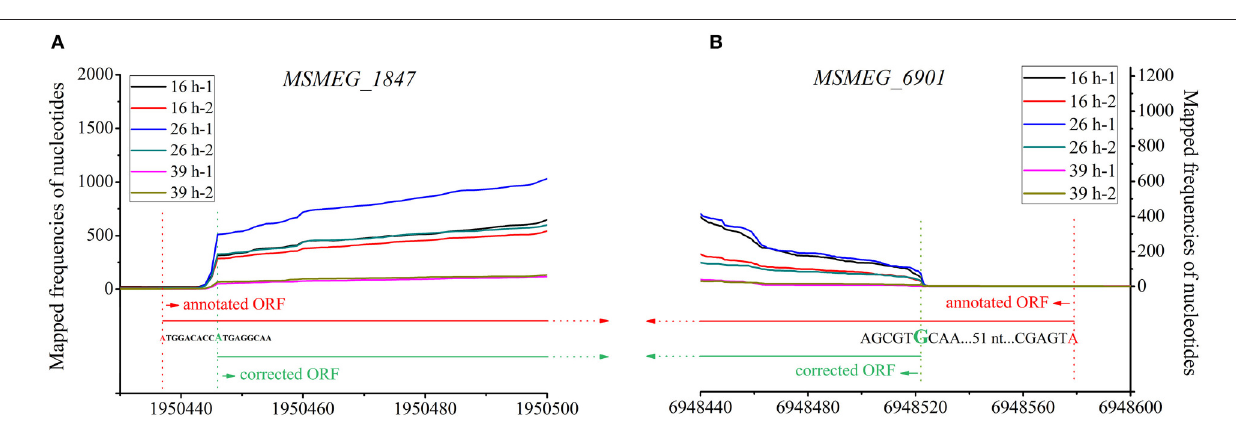
FIGURE 8 | Transcriptional maps and gene structural re-annotation of MSMEG_1874 (A) and MSMEG_6901 (B) . The nucleotides in red and red dot lines indicate the start codons annotated by algorithms-based software. The nucleotides in green and green dot lines indicate the TSS determined by RNA-seq, and these TSSs are also considered to be the accurate start codons of relevant